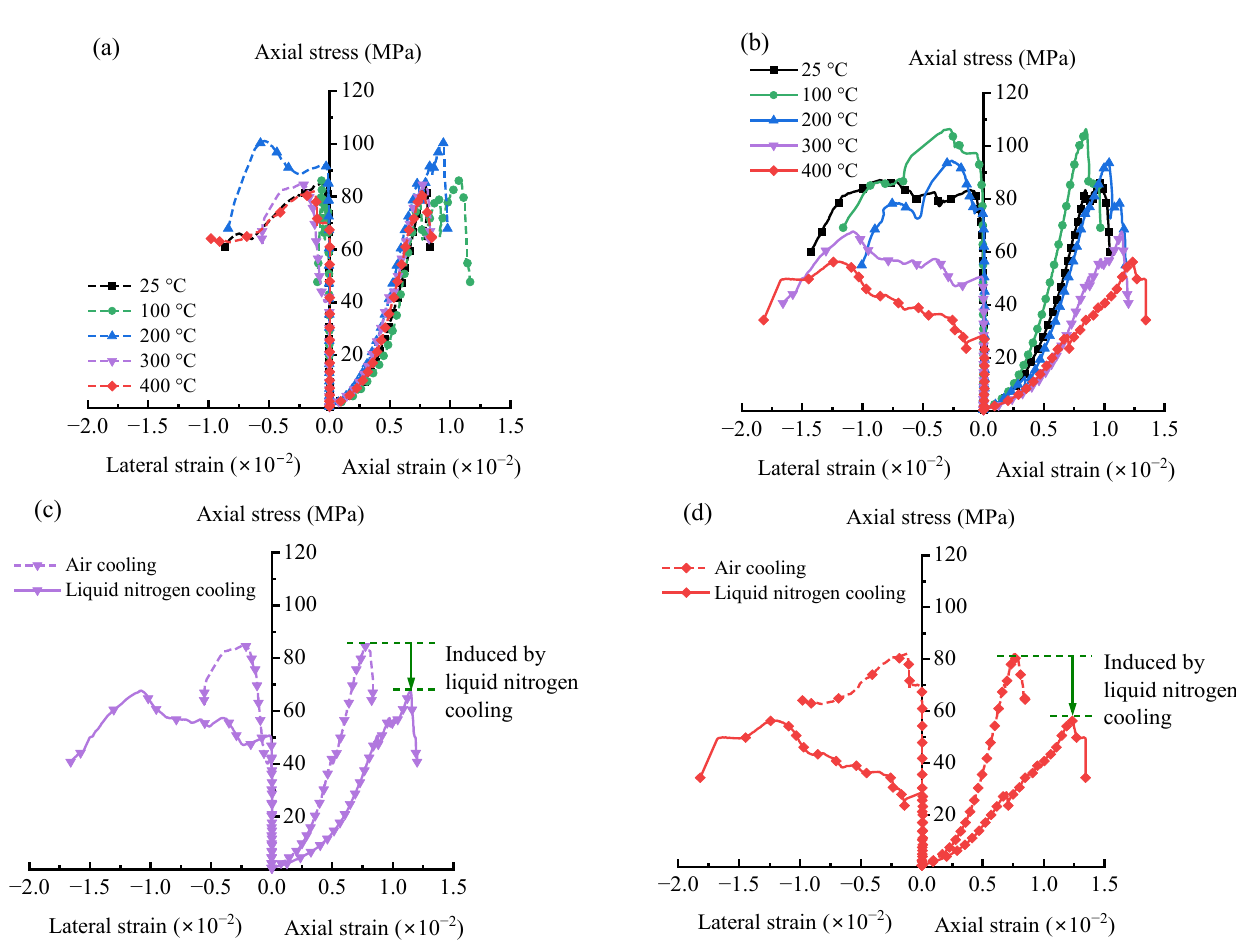
Figure 3. Stress–strain curves in uniaxial compression of specimens under: ( a ) air cooling and ( b ) liquid nitrogen cooling ( c ) at 300 °C and ( d ) at 400 °C.